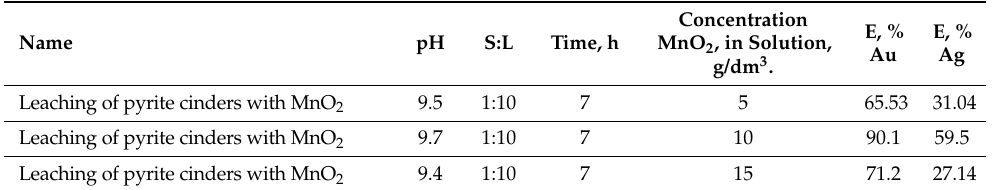
Table 8. Results of leaching of residue after thermochemical activation in the presence of man- ganese